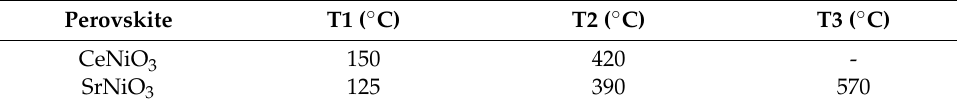
Table 1. DTG decomposition temperatures of SrNiO 3 and CeNiO 3 perovskites.